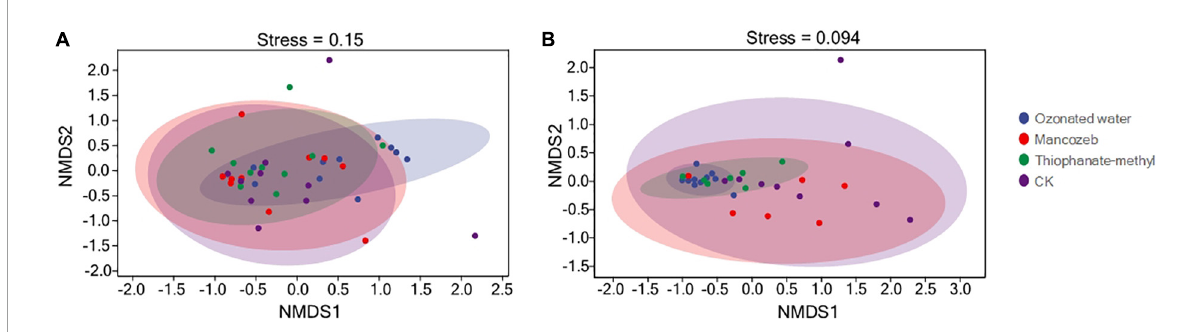
FIGURE1 Analysis of microbial beta diversity among different treatment groups. (A) Non-metric multidimensional scaling (NMDS) analysis of bacteria; (B) NMDS analysis of fungi.